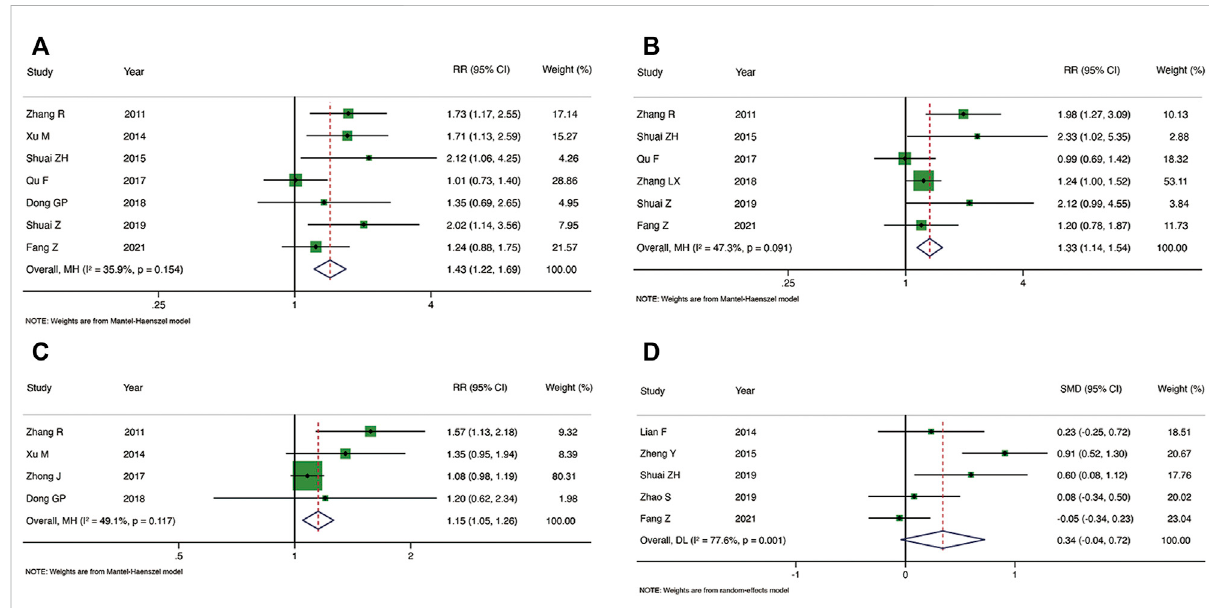
FIGURE 4 Meta-analysis of the embryo implantation rate (A) , live birth rate (B) , biochemical pregnancy rate (C) and the number of oocytes retrieved (D) .